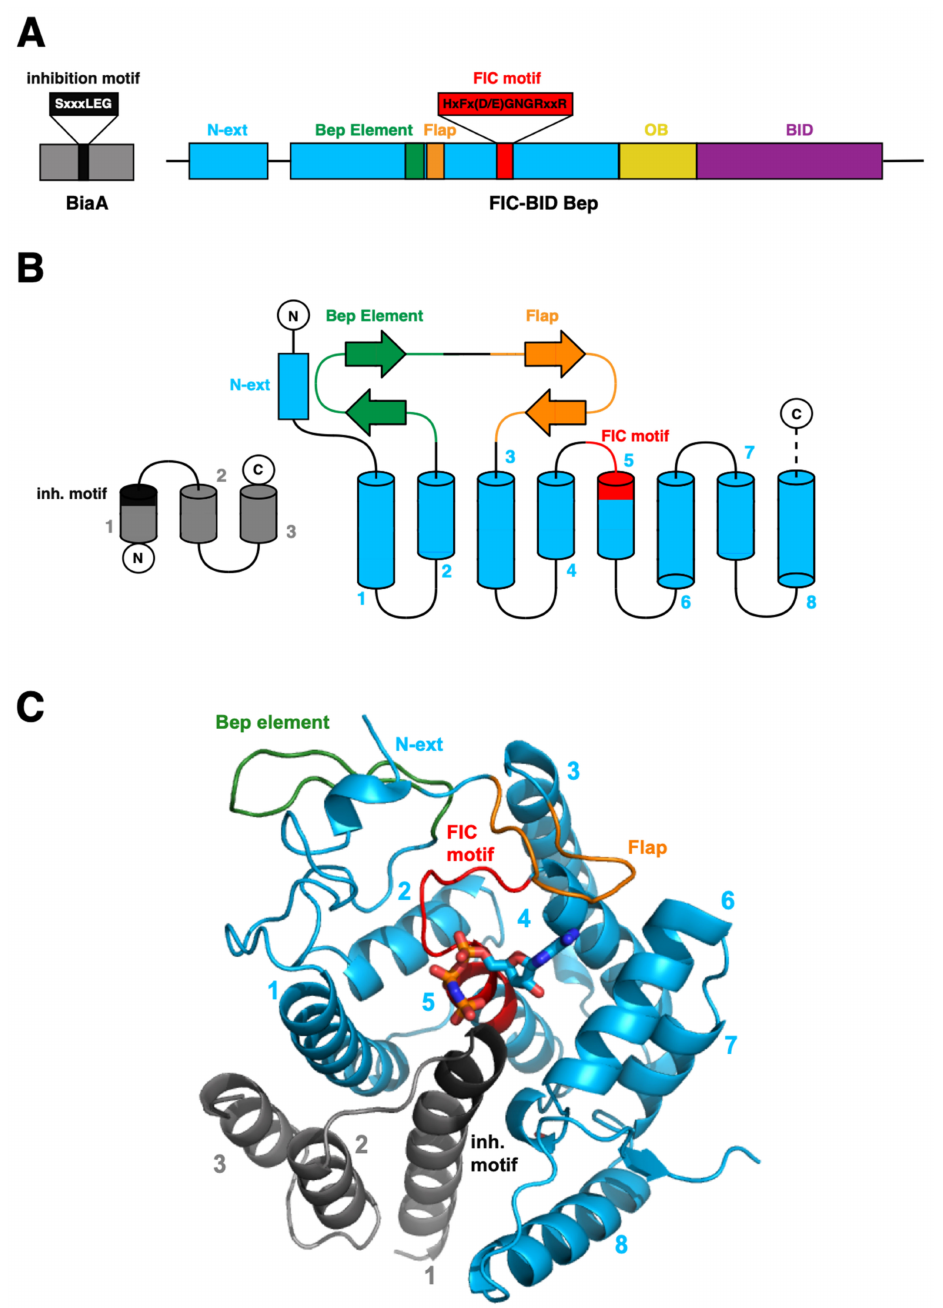
Figure 2. Structural organization of the BepFIC-domain and the interacting BiaA antitoxin. ( A ) Domain organization of FIC-BID proteins characterized by the FIC-fold with an N-terminal extension (N-ext) shown in blue, followed by an OB-fold domain (yellow) of unknown function and the BID-domain (magenta), which, together with the positively charged C-terminus, are responsible for T4S system-mediated secretion. ( B ) Topology of the BepFIC fold consisting of N-ext (blue), helices α 1 to α 8 (blue), and two β -hairpins (Bep element in green; flap in orange) between α 2 and α 3. The signature motif locates to the α 4- α 5 loop and the N-terminal end of α 5 (both shown in red) that form the major part of the active site. The topology of the separate BiaA antitoxin is shown in grey. ( C ) Cartoon representation of the BepFIC domain of Bhe _BepA in complex with antitoxin Bhe _BiaA (PDB ID: 5NH2). The ATP substrate analog AMPPNP shown in sticks has been modeled based on the Btr _BepC/AMPPNP complex structure